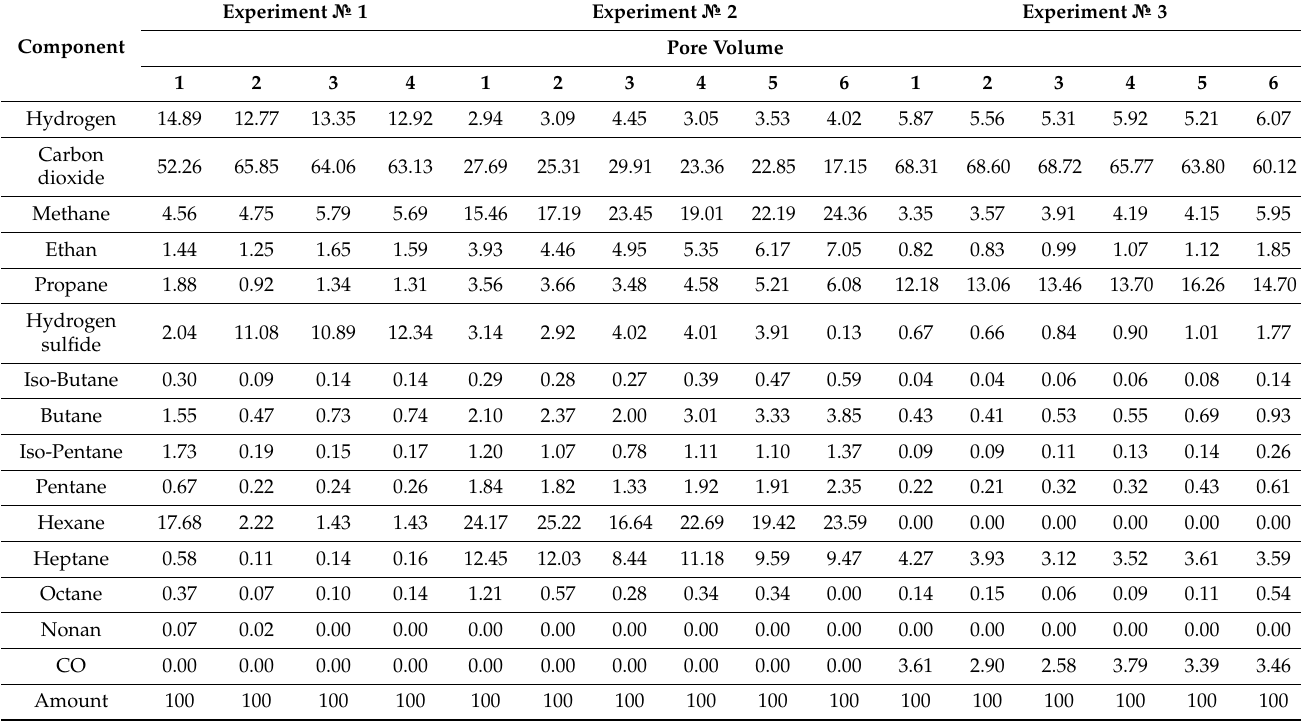
Table 3. Component composition of gas at the fluid separation line in the experiments (mol %).